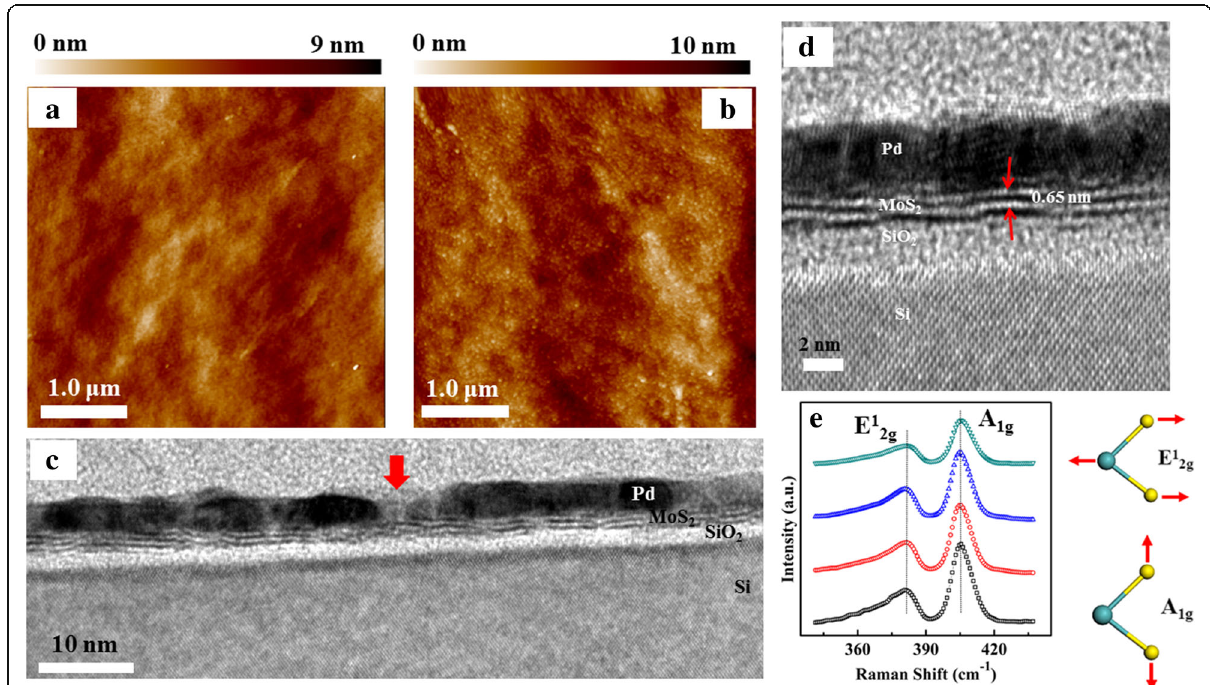
Fig. 2 AFM images of the MoS 2 layers a without Pd decoration, and b with 5-nm Pd decoration. c HRTEM image of the Pd-decorated MoS 2 layers on the Si substrate. The red arrow denotes the gap between two Pd nanoparticles. d Enlarged HRTEM image. e Typical Raman spectra of the as-grown MoS 2 layers on Si from different regions of the